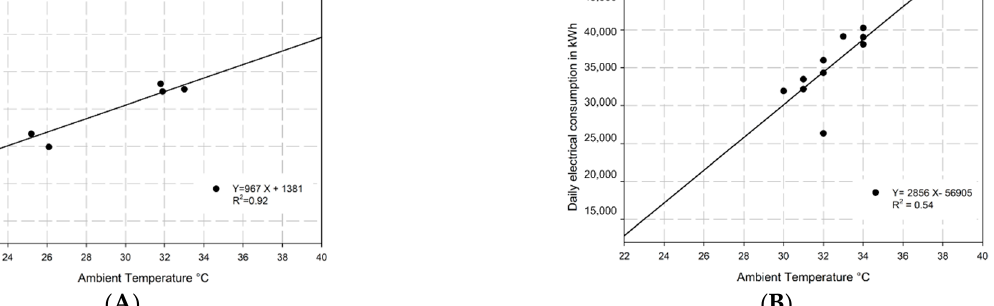
Figure 6. Different linear relationships between ambient temperature and measured electrical con- sumption in the UJ campus for Mondays in different intervals A and E from Table 2. ( A ) Mondays in spring term from 25 March 2019 to 29 April 2019 (Interval A) and ( B ) Mondays in fall academic term from 2 September 2019 to 11 November 2019 (Interval E).